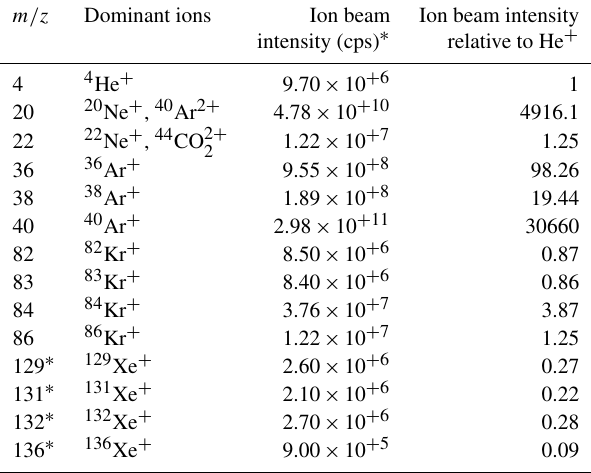
Table 2. Summary of observed ion beams in Fig. 4. Relative ion beam intensities on MAT 253 are calculated from the scan with identical source tuning. Xe isotope beams were not observed but scaled from previous observations in the